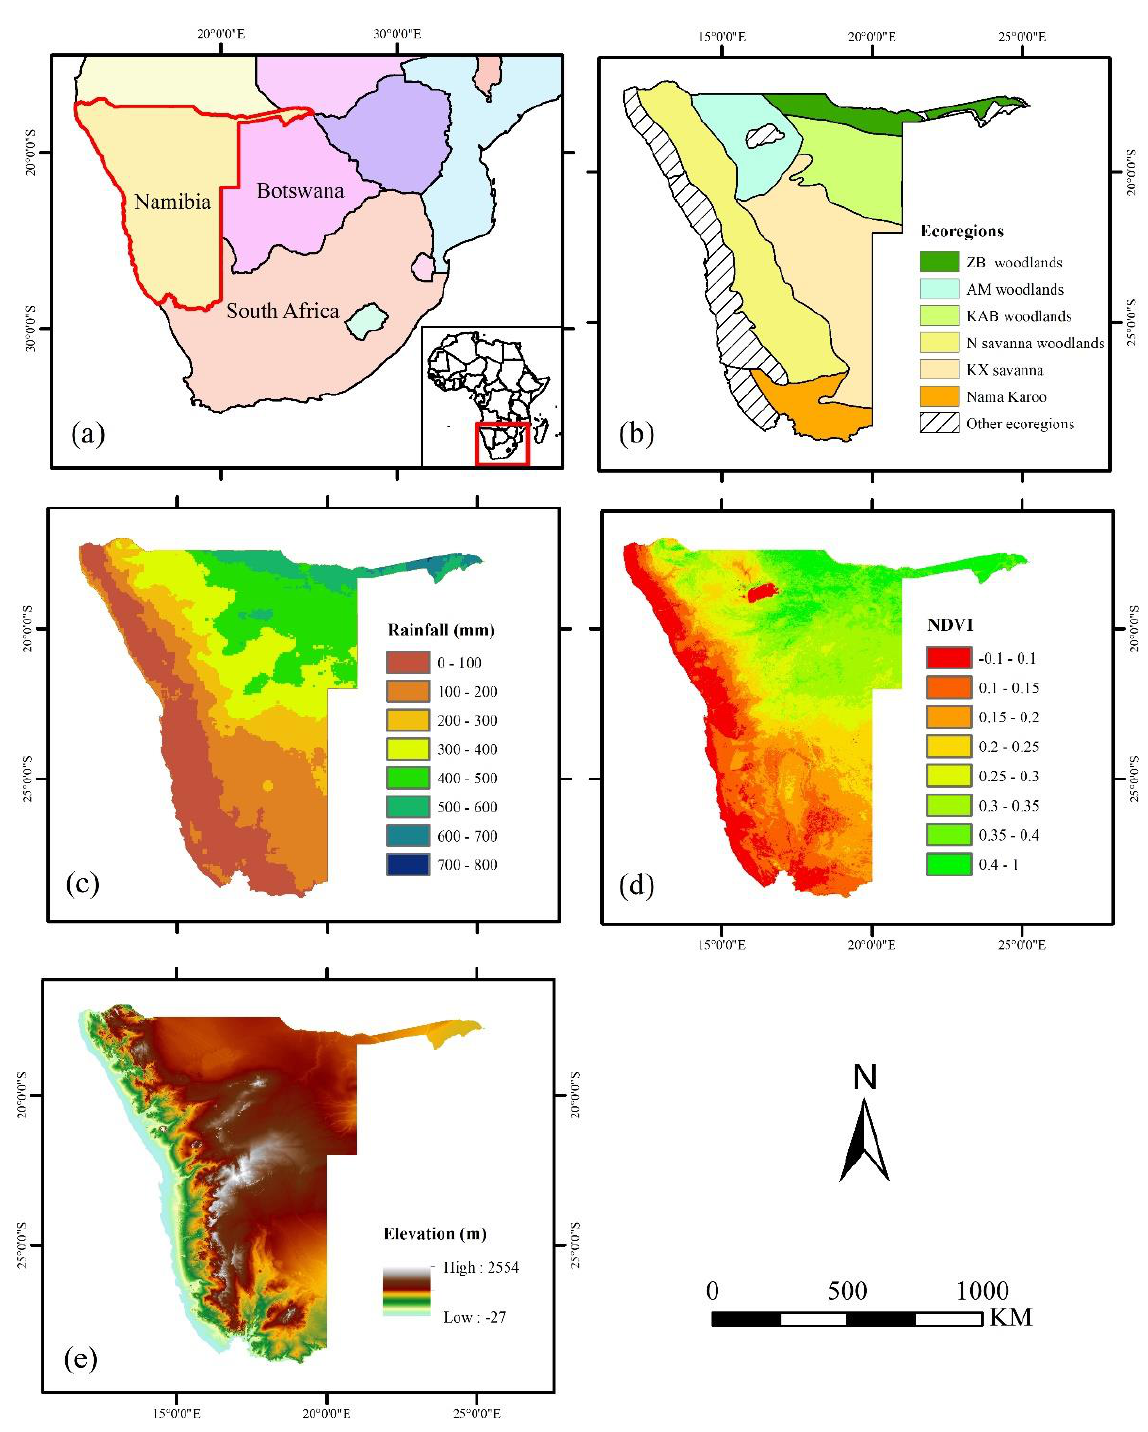
Figure 1. ( a ) Geographical location; ( b ) Ecological Division; ( c ) Average annual rainfall (2001–2020); ( d ) Average NDVI (2001–2020); and ( e ) Elevation of